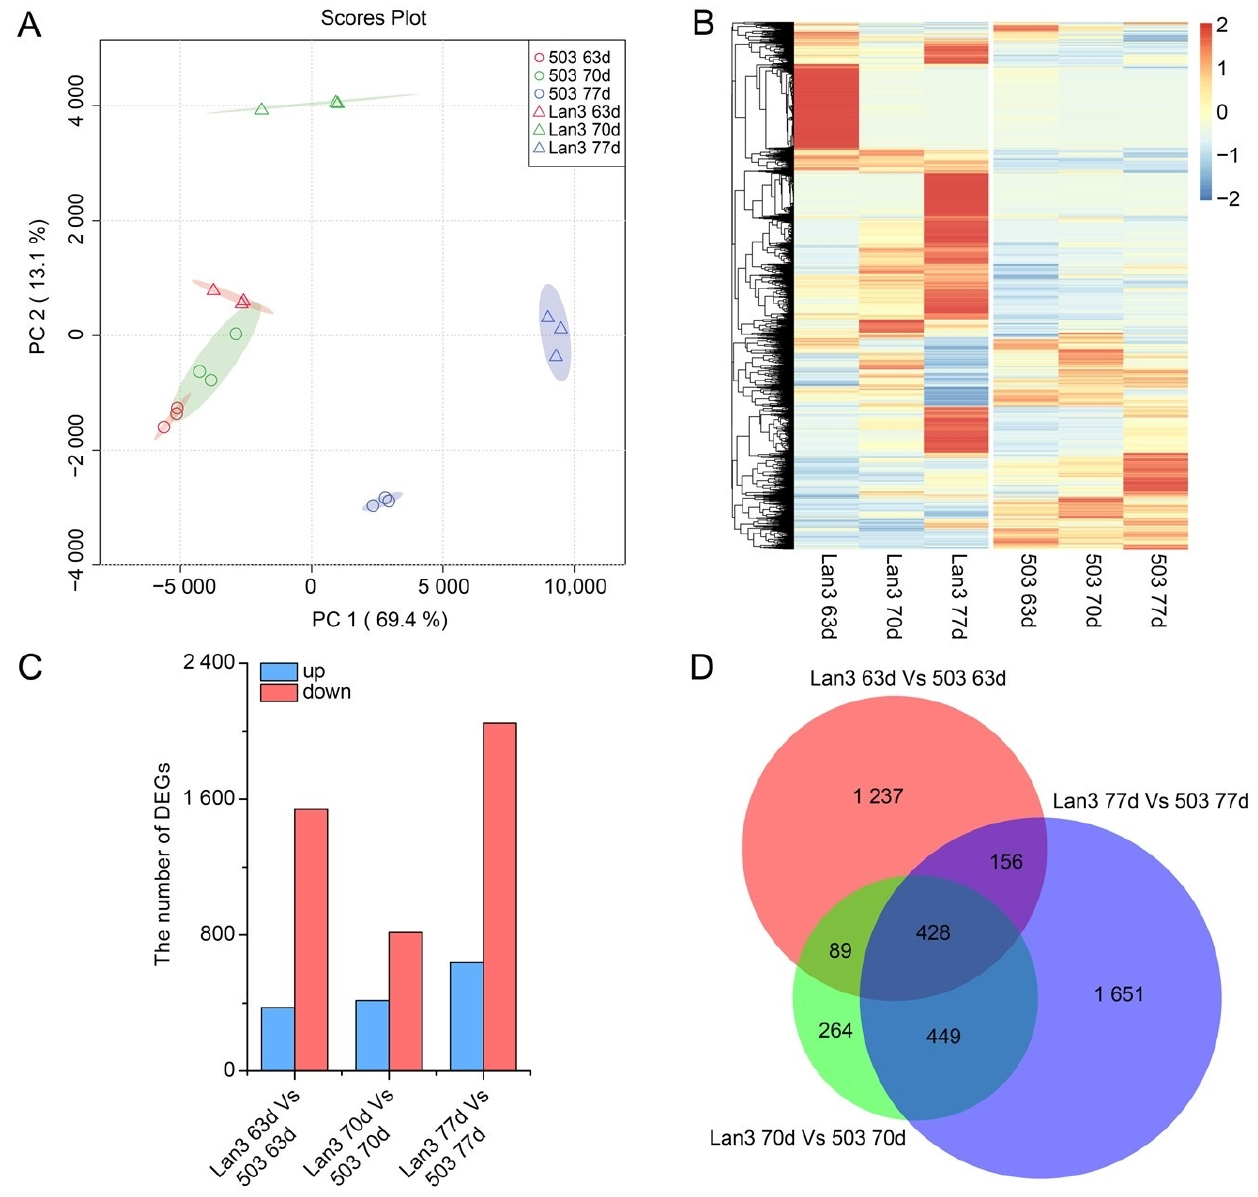
Figure 2. Summary of the differentially expressed genes. ( A ) PCA score plot. ( B ) Heat map of all Figure 1. ( a ) Geometry and dimensions of the axisymmetric dumbbell specimens used in the fatigue DEGs. ( C ) A summary of the numbers of up- and down-regulated DEGs 63, 70, and 77 DAS. ( D ) The experiments; ( b ) geometry of the Cracked Round Bar (CRB) specimen; ( c ) Section A-A of the CRB Venn diagram represents the number of overlapping DEGs between Lan3 and specimen with the circumferential notch.